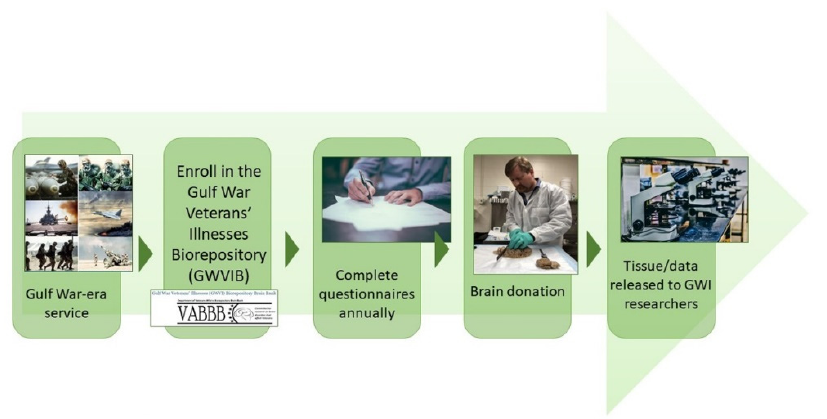
Figure 1. Gulf War Veteran’s Pathway to Participation in the Gulf War Veterans’ Illness Biorepository.